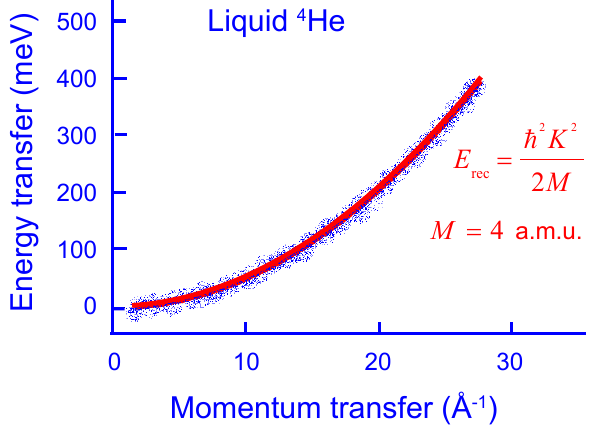
Figure 2: Schematic representation of measured dynamic structure factor S ( K , E ) of liquid helium [47]. The red line is the calculated recoil parabola, Eq. (13), for the mass of 4 He, shown as a guide to the eye. The white-blue ribbon around the recoil parabola represent data points measured with the time- of-flight spectrometer ARCS [48] (Adapted from [47, Fig.